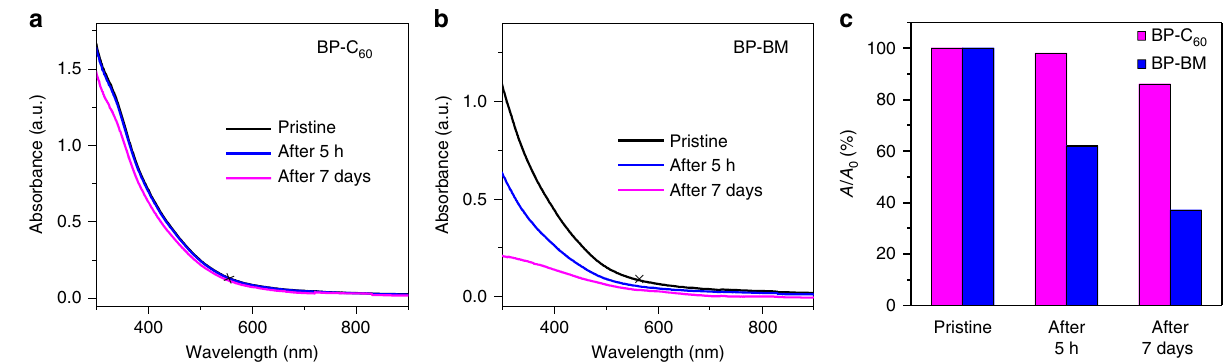
Fig. 3 Stabilities of the BP-C 60 hybrid and BP-BM dispersions in water. UV-vis absorption spectra of the BP-C 60 hybrid ( a ) and BP-BM ( b ) dispersed in water after standing for different times. c Variation of the absorption ratios ( A / A 0 ) at 550 nm (marked by a cross) of BP-C 60 and BP-BM dispersions with